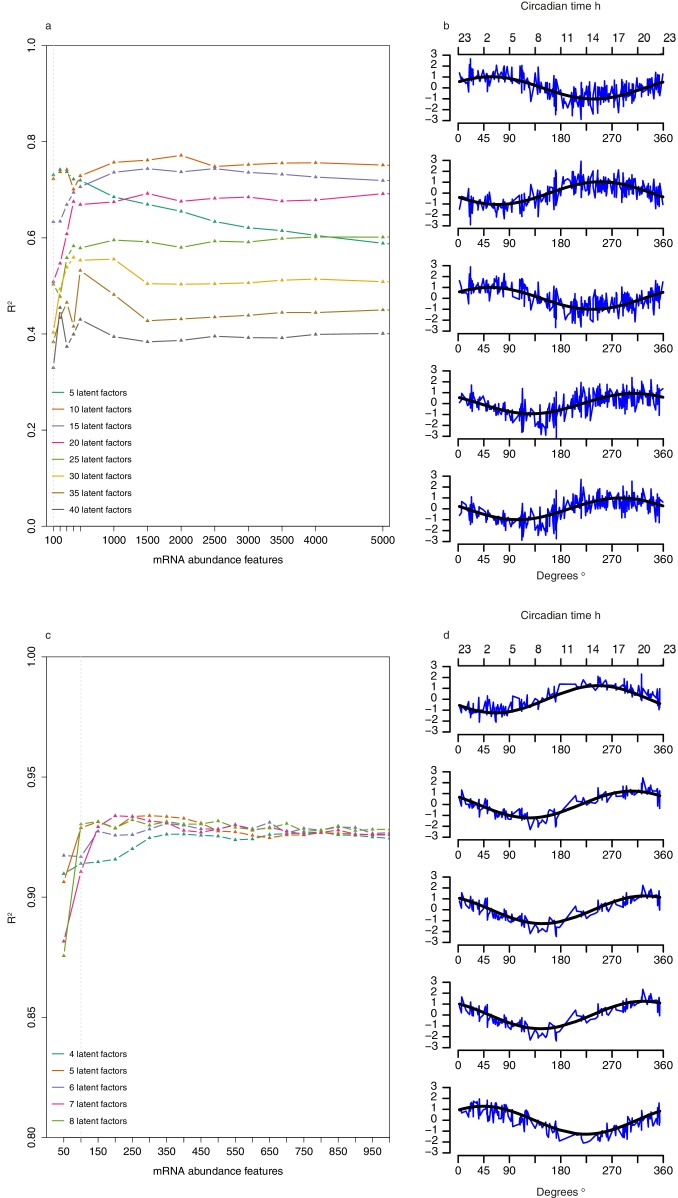
Selection of number of abundance features and latent factors and pseudo time-course of latent factor scores for Partial Least Squares Regression (PLSR)-based models.(a) Leave-one-participant-out cross-validation performance of one-sample PLSR models applied to training set when using different combinations of n mRNA abundance features and T latent factors. (b) Pseudo-time course of latent factor scores for each of the five latent factors used to build the one-sample PLSR-based model; x-axis comprises the 329 samples in the training set ordered by their true circadian phase vs. y-axis of corresponding z-scored latent factor score (a linear combination of the 100 feature values used to generate the model multiplied by the corresponding latent factor loadings [weights]) for the sample. Black line represents the fitted cosine wave to the pseudo time-course. (c) Leave-one-participant-out cross-validation performance of two-sample differential mRNA abundance PLSR models applied to training set when using different combinations of n mRNA abundance features and T latent factors. (d) Pseudo-time course of factor scores for each of the five latent factors used to build the two-sample differential PLSR-based model; x-axis comprises the 163 paired samples in the training set ordered by their true circadian phase vs y-axis of corresponding z-scored latent factor score (a linear combination of the 100 feature values used to generate the model multiplied by the corresponding latent factor loadings [weights]) for the sample. Black line represents the fitted cosine wave to the pseudo time-course.